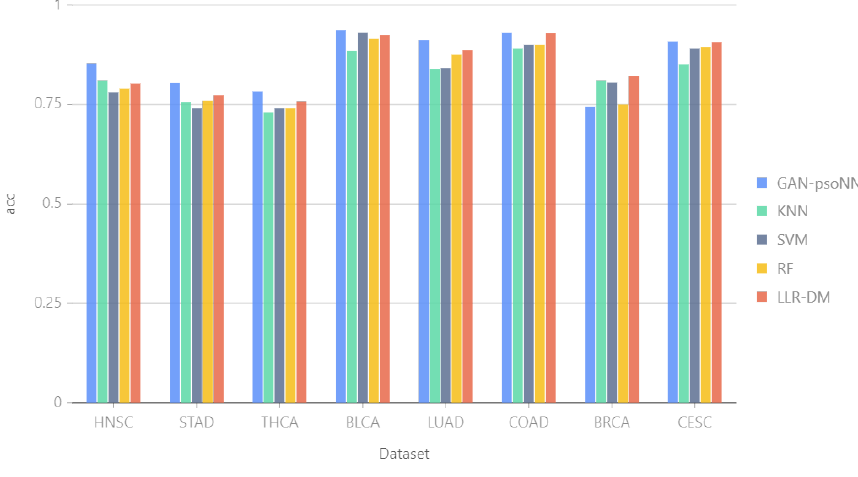
Figure 3. The accuracies using WGAN-psoNN, KNN, SVM, RF and LLR-DM classifiers to predict lymphatic